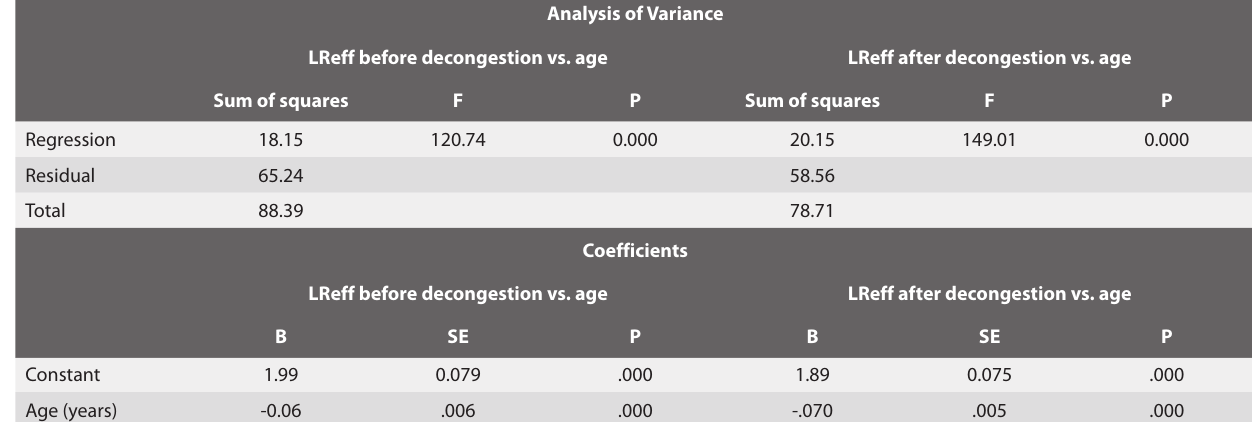
Table 5. Results of the regression analysis (both